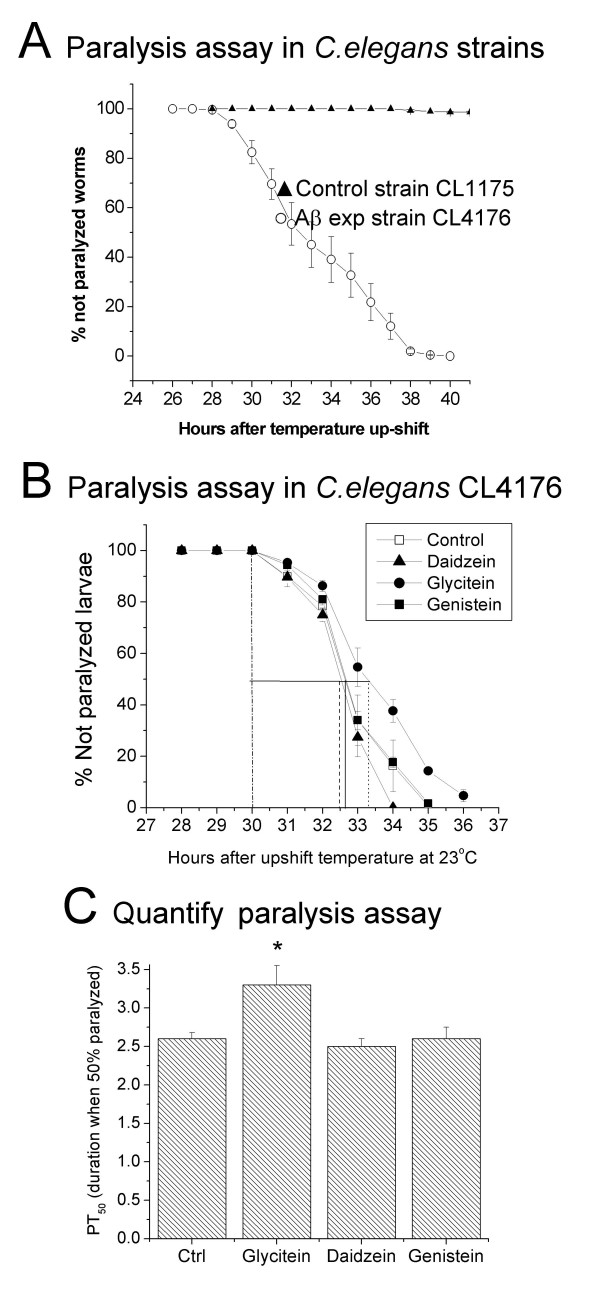
Paralysis assays in the transgnic C. elegans. A. Time course of paralysis in the transgenic strain CL4176 and the control strain CL1175. B. Paralysis assay in C. elegans CL4176 fed with different isoflavones. Synchronized eggs were maintained at 16°C for 38 h, on the 35 × 10 mm culture plates (~100 eggs/plate) containing vehicle (control), daidzein, glycitein, or genistein (100 μg/ml), followed by up-shifting the temperature to 23°C to induce the transgene expression. The paralysis was scored at 60 min intervals. Data are expressed as percentage of non-paralyzed worms from three independent assays of 100 worms in each experiment. C. The paralysis assays were quantitated for mean time duration at which 50% worms were paralyzed from 30 hrs after up shift temperature to 23°C (PT50). P values were obtained from 3 independent assays for the worms fed with different drugs each paired with untreated controls. Total 100 worms were used in each assay.